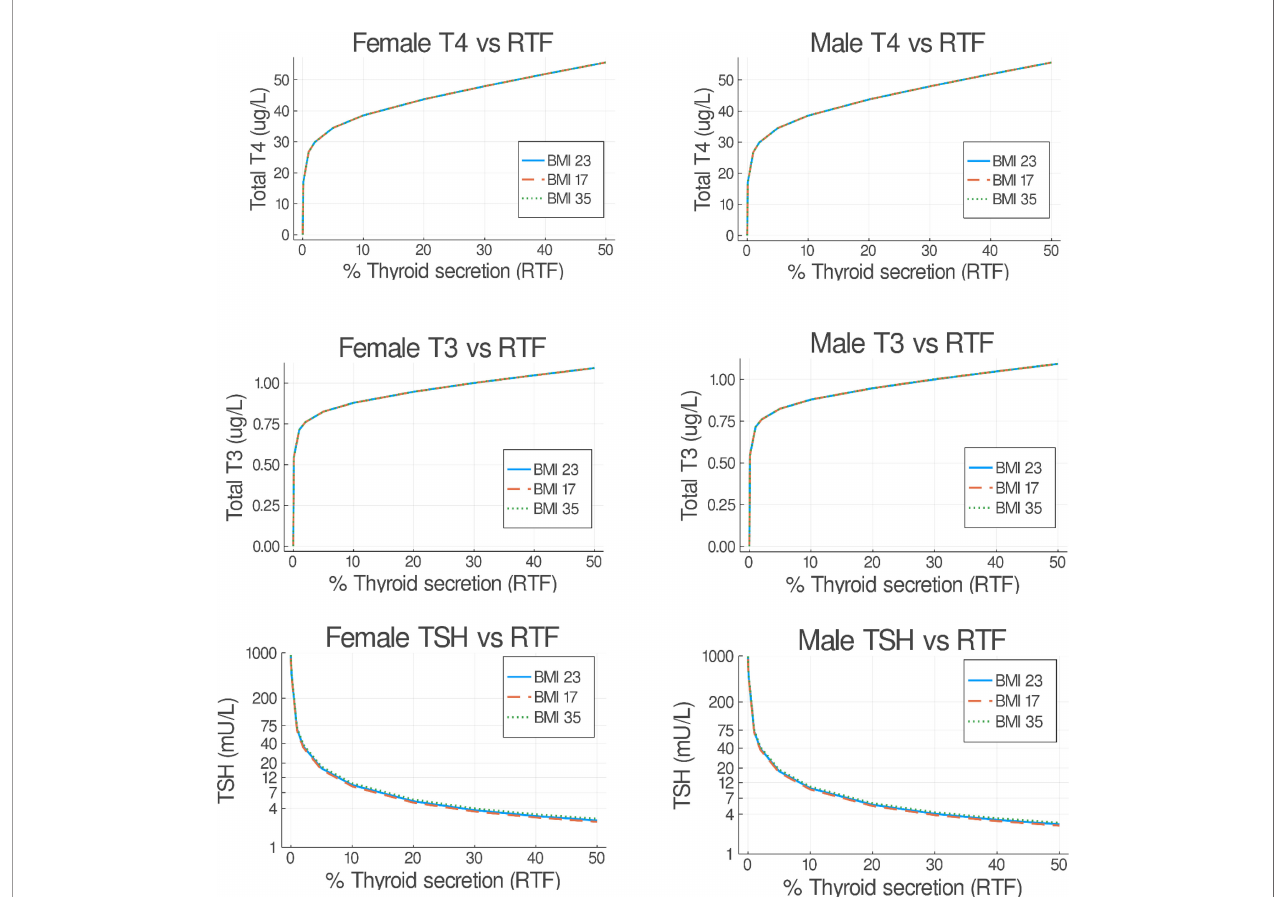
FIGURE 7 | Predicted steady-state serum T3/FT4/TSH concentrations versus residual thyroid function (RTF) values. Untreated underweight, normal, and obese patients were simulated for 50 days. The fi nal steady-state T4/T3/TSH simulation values (as in Figure 3 ) are shown on the abscissa for each RTF value on the ordinate axis, separated into female (left) and male (right) plots. Notably, all resulting BMI plots